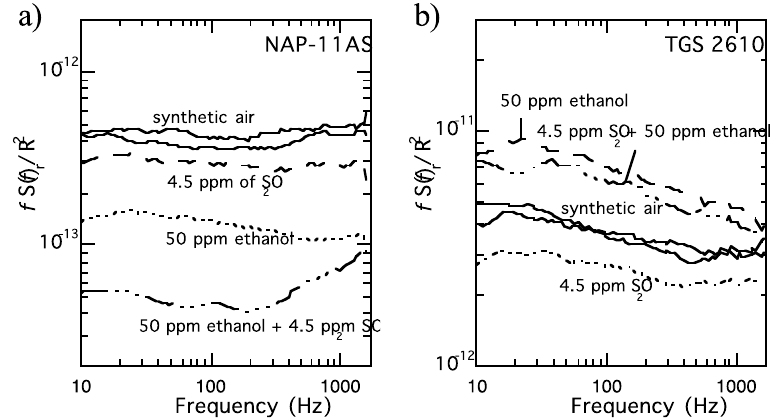
Figure 4. Experimental proof that the response in Taguchi sensors is not additive (nonlinear) [55]. Both in the case of the sensor NAP-11AS ( a ) and of the sensor TGS 2610 ( b ), the response to a mixture of two chemicals (ethanol and S 2 O) is not the sum of the responses obtained when each chemical is alone in the test chamber.